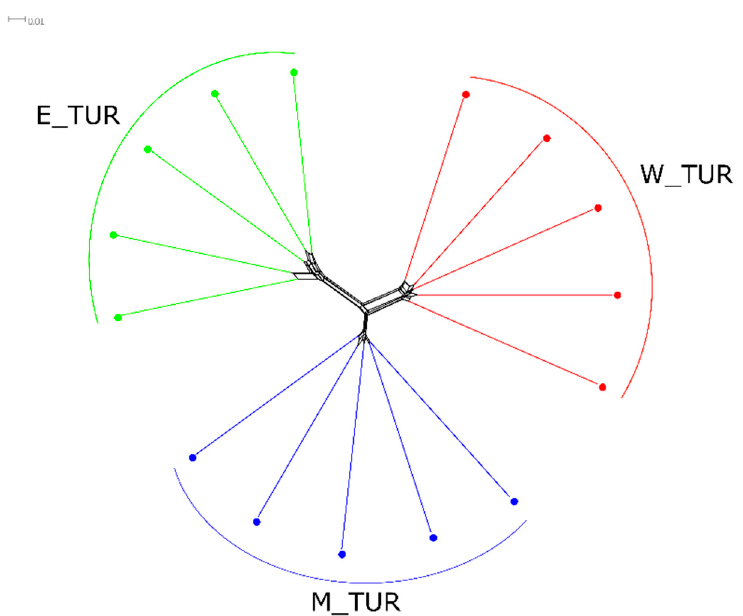
Figure 6. Neighbor-Net dendrogram of 15 Caucasian tur ( Capra caucasica ) individuals, based on Figure 6. Neighbor ‐ Net dendrogram of 15 Caucasian tur ( Capra caucasica ) individuals, based on IBS IBS distances.